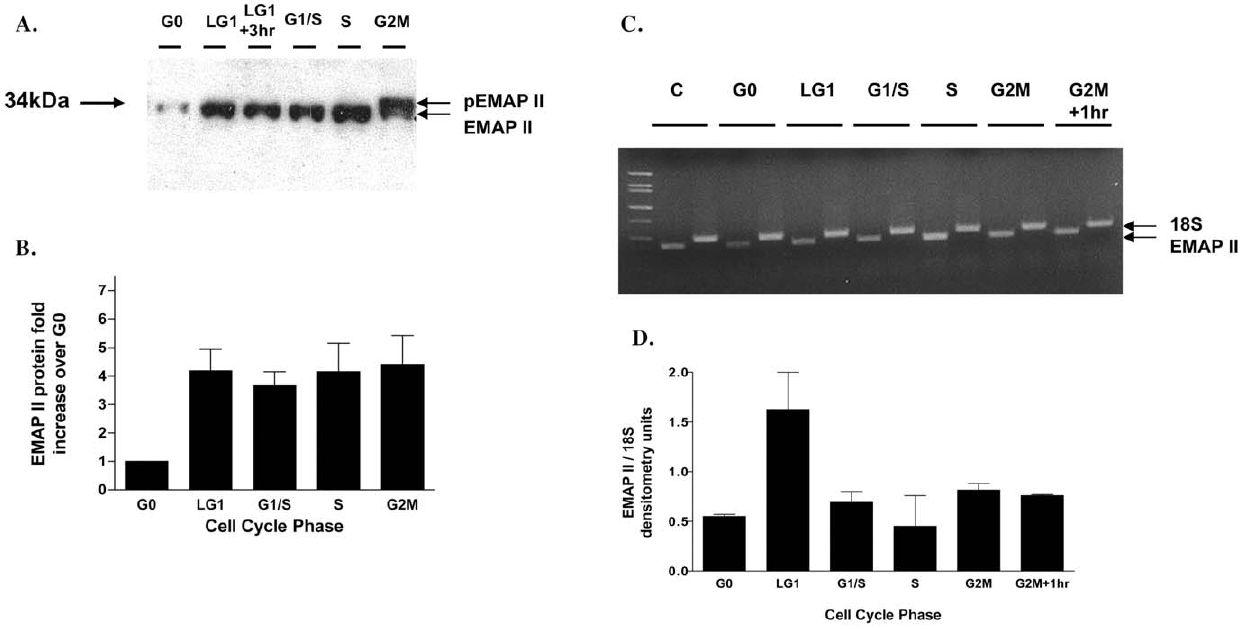
Figure 3. EMAP II is phosphorylated at G2M phase of cell cycle. EMAP II translation and transcription were examined in chemically synchronized cells throughout the phases of cell cycle. Western blot analysis indicated that upon exiting G0, EMAP II protein was increased throughout cell cycle and was phosphorylated at G2M (A,B). EMAP II transcription was minimally impacted during the different phases of cell cycle (C,D) (these experiments were performed a minimum of 4 times).